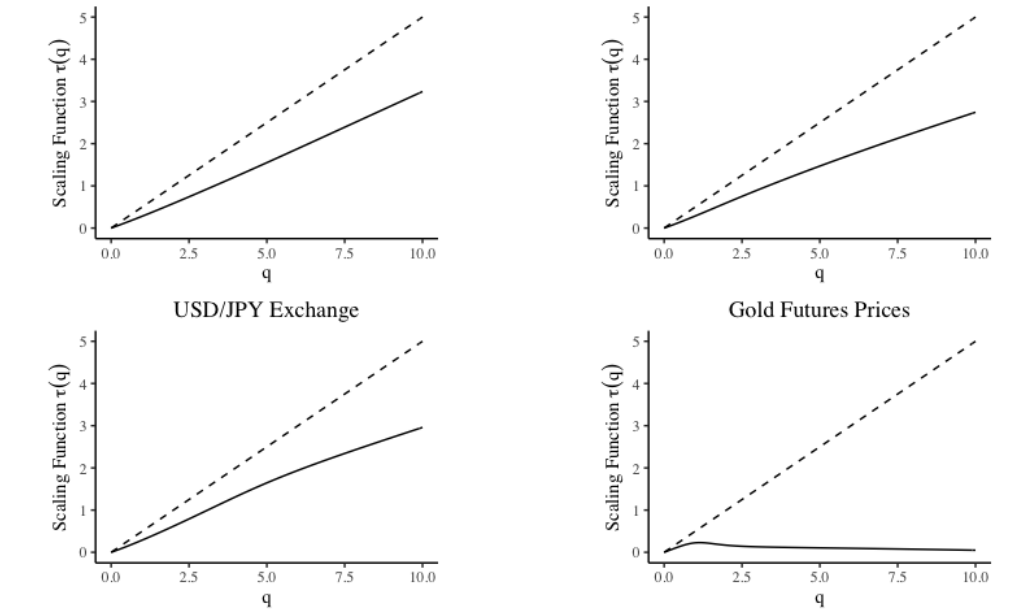
Figure 12. Scaling functions for S&P500, NASDAQ Index, USD/JPY Exchange and Gold Futures Prices the period 4 March 1988 to 3 September